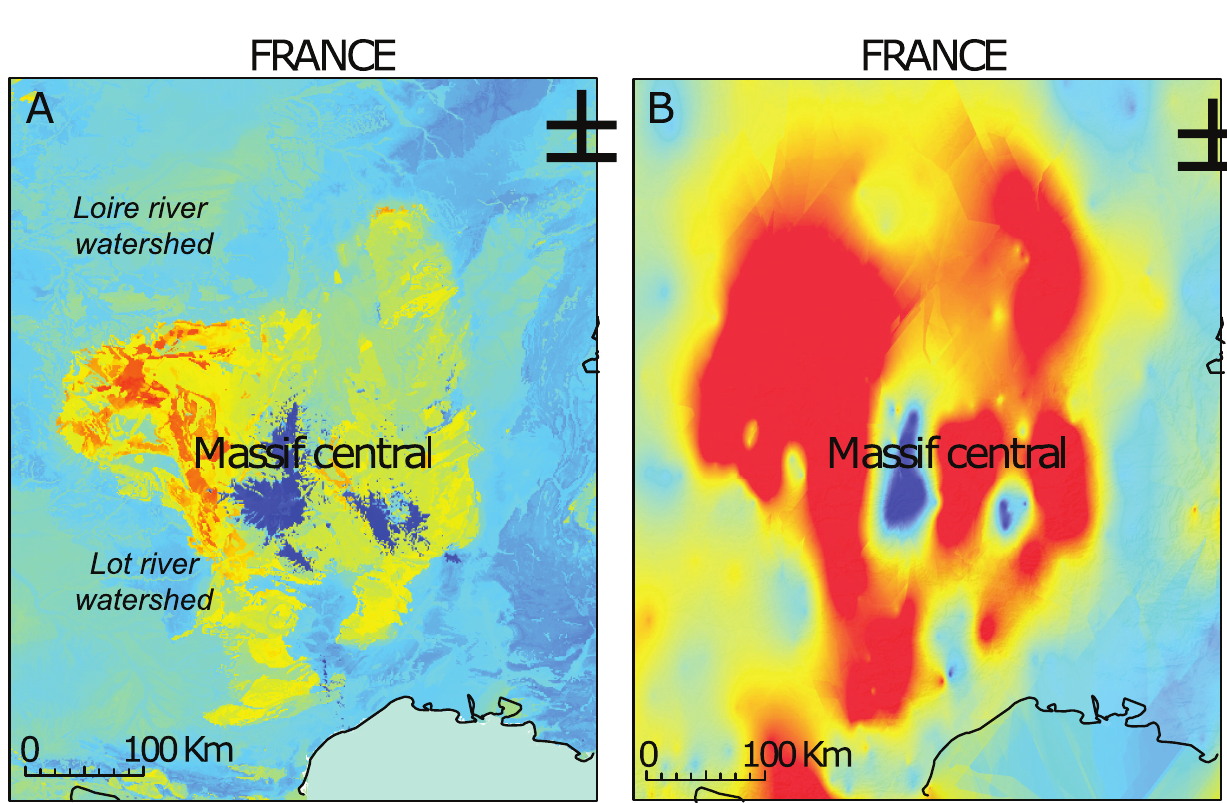
Fig 10. Bioavailable 87 Sr/ 86 Sr maps for the Massif Central. A. Random forest regression bioavailable 87 Sr/ 86 Sr map; B. Ordinary kriging bioavailable 87 Sr/ 86 Sr map. Color scale is the same as Fig 9. Coastline features are from http://www.naturalearthdata.com/.